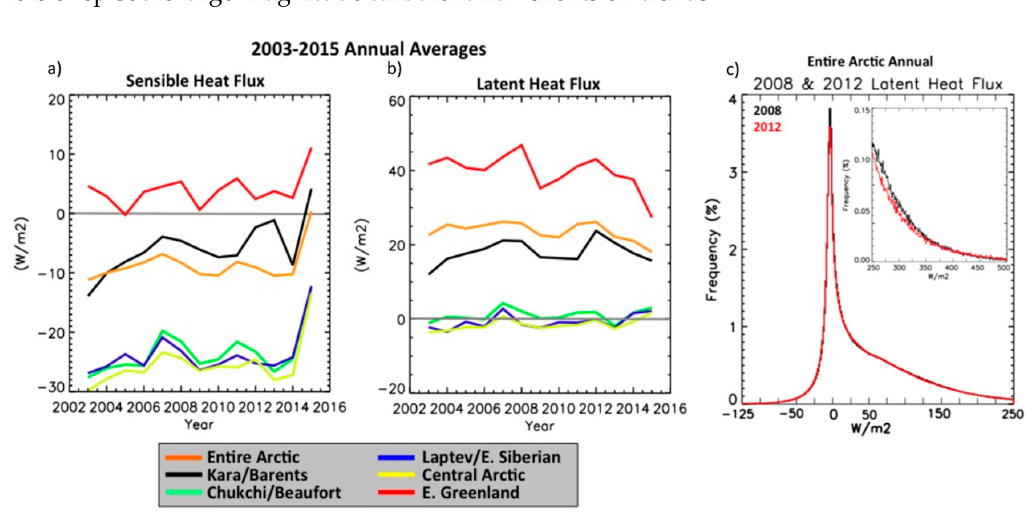
Figure 9. Left and center panels show the satellite-retrieved annual, Arctic domain-averaged ( a ) SH and ( b ) LH time series (orange line) between 2003 and 2015 and several other regions (see legend). ( c ) The probability distribution function of daily LH flux values across the Arctic Ocean for 2008 (black) and 2012 (red), the inset highlights the long positive tail.